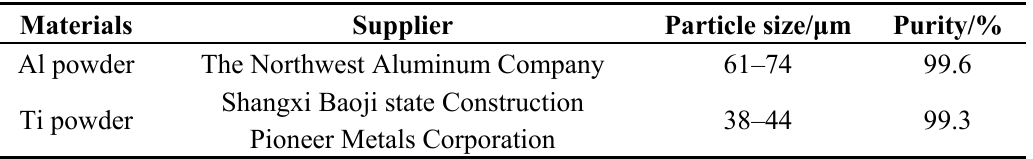
Table 3. Characteristics of